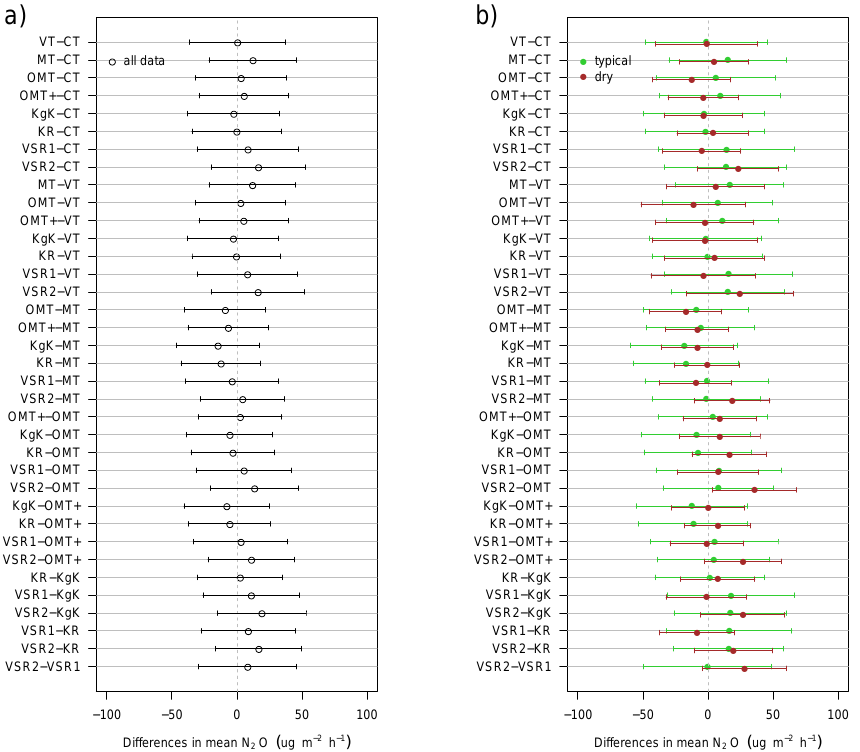
Figure 6. The post hoc Tukey differences (error bars for 95% confidence intervals) of mean N 2 O (µgm − 2 h − 1 ) fluxes from the forest floor for the pairwise comparisons of forest/mire types (uplands – CT, VT, MT, OMT; transitions – OMT + , KgK, KR; and mires – VSR1, VSR2): (a) the N 2 O flux differences over the whole period for a typical and dry year, (b) the N 2 O flux differences only for snowless seasons and separately for typical and dry